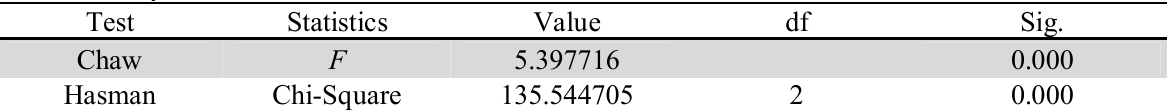
The summary of some statistical